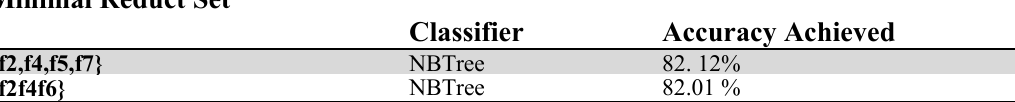
Minimal Reducts Minimal Reduct Set